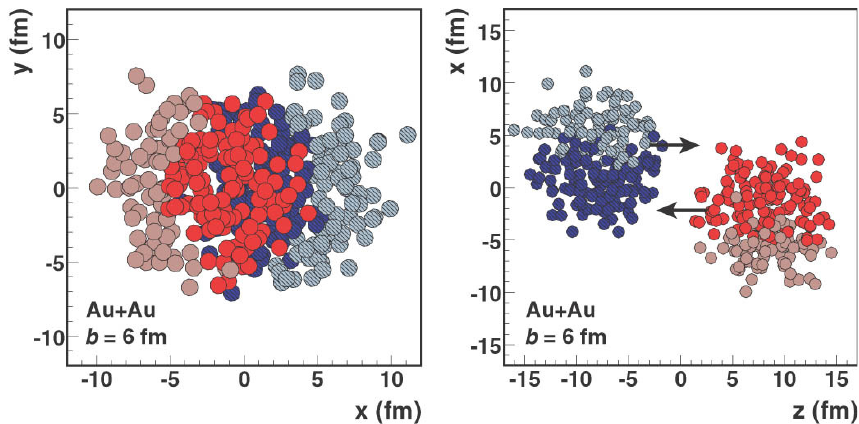
√ s = 200 GeV) viewed in the transverse plane NN